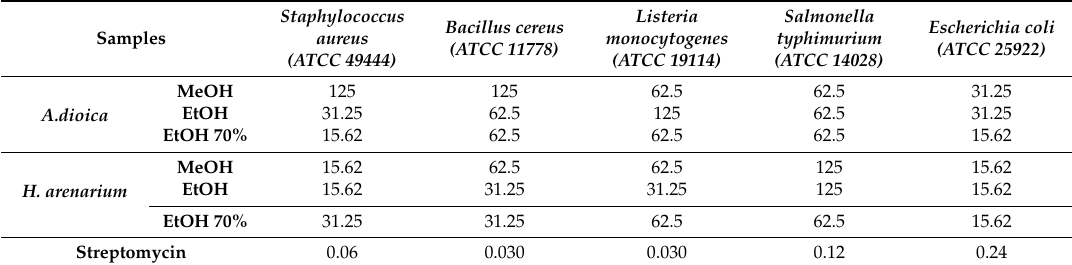
Table 7. Minimum bactericidal concentration—MBC (mg/mL) of H. arenarium and A. dioica extracts and standard